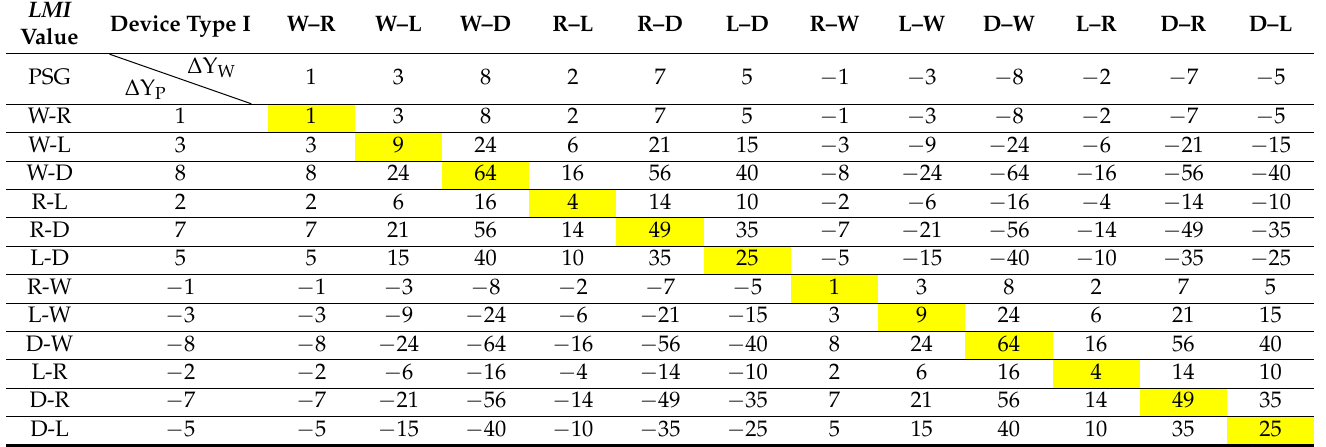
Table A1. Detailed LMI table for the evaluation of the type I sleep tracker. The localized mismatch index values between wearable device type I and PSG with “W” annotated for Wake, “R” for REM, “L” for Light, “D” for Deep and the operation ‘-‘for the transition between sleep stages (i.e., W-L, Wake to Light